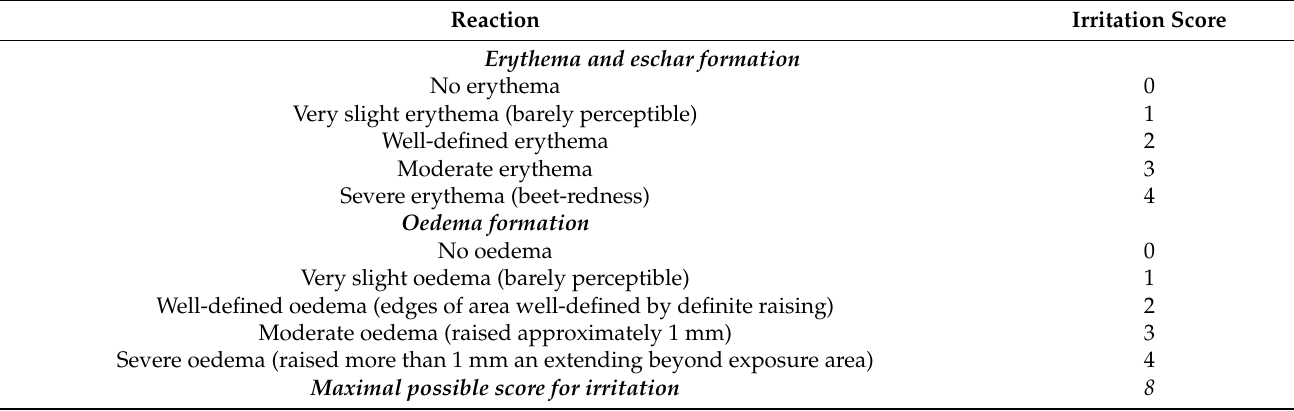
Table 2. Scoring system for skin reaction.